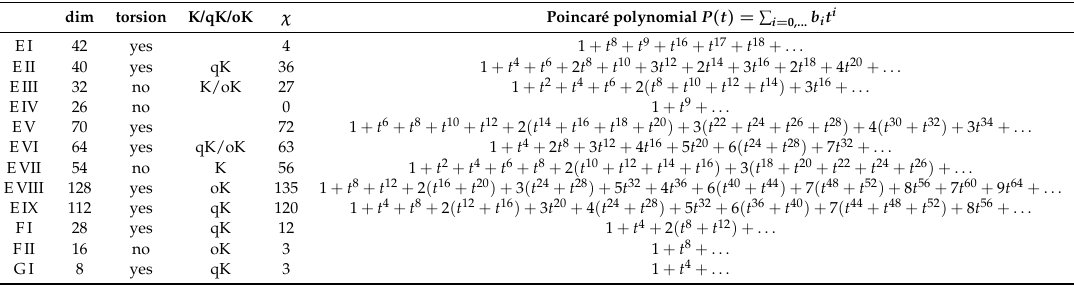
Table 6. Exceptional, compact type, symmetric